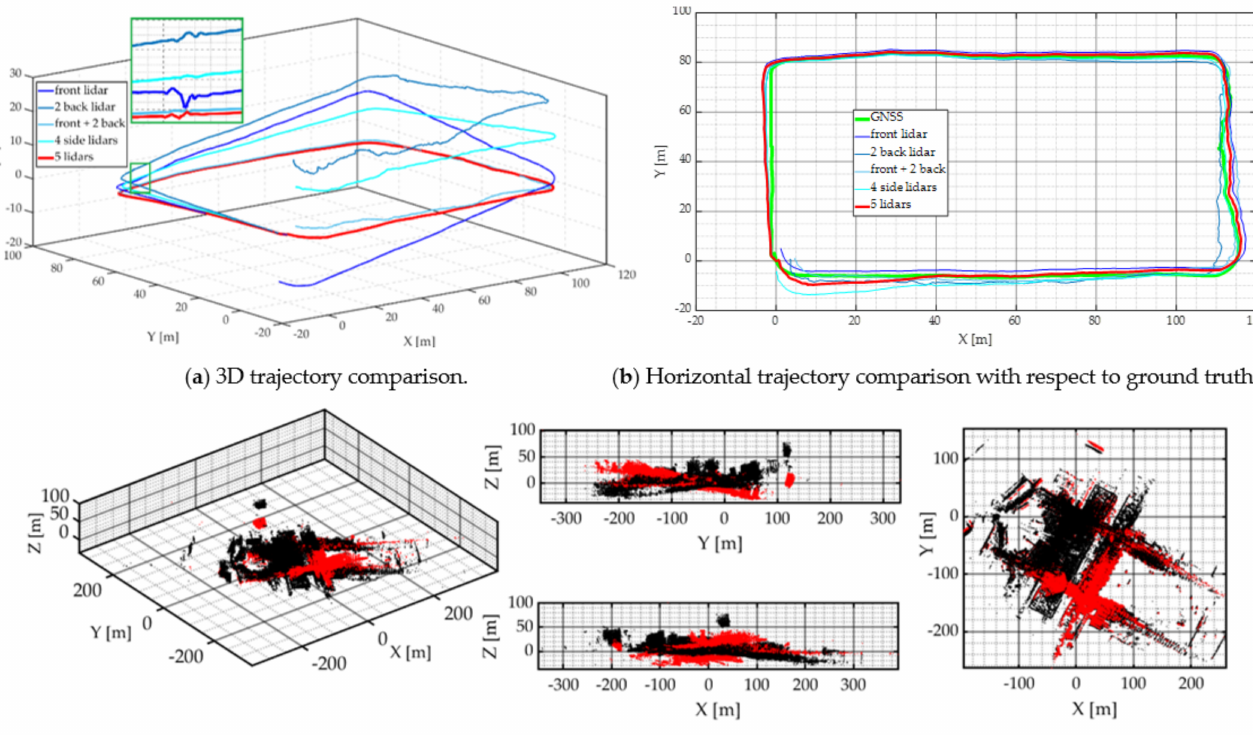
Figure 13. Illustration of multi-lidar fusion